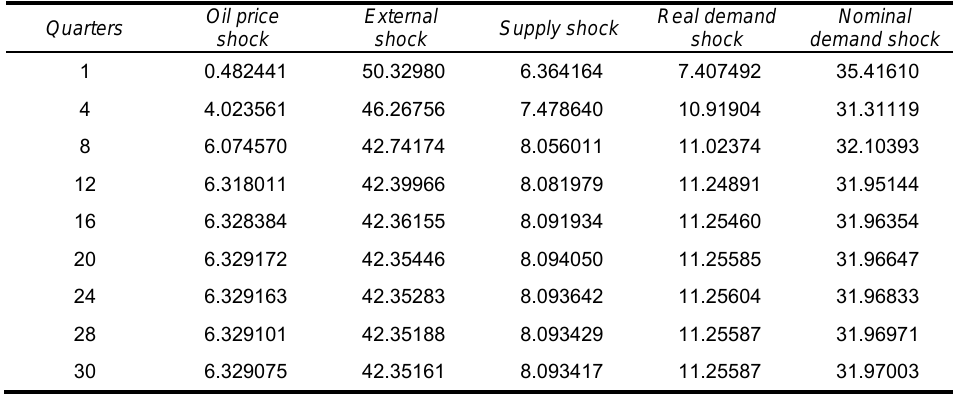
Table 7. Variance decomposition of the trade